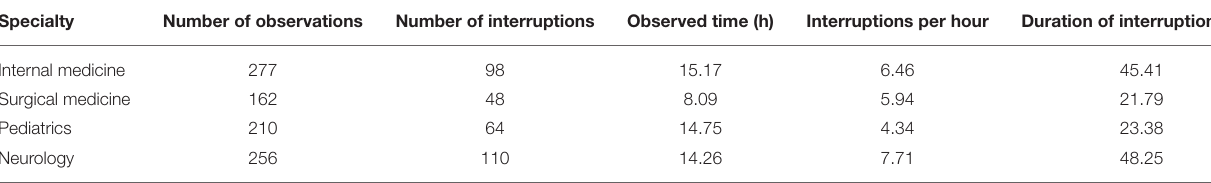
TABLE 5 | Observed workflow interruptions grouped by the four specialties.